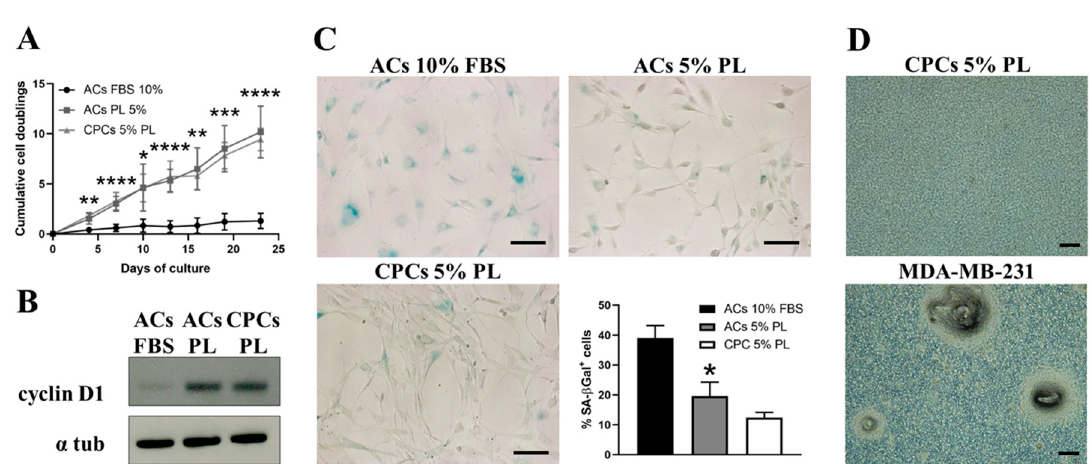
Figure 2. Growth rate and senescence profile of ACs and CPCs and in vitro tumorigenesis test on CPCs. ( A ) Growth kinetics plotted as number of cell duplications versus time of culture: black line indicates ACs expanded in presence of 10% FBS, grey line for ACs in 5% PL and light grey line for CPCs in 5% PL. Data are represented as mean ± SD ( N = 6, * p < 0.05, ** p < 0.01, *** p < 0.001 and **** p < 0.0001 versus ACs 10% FBS at the same time point by Student’s t -test analysis). ( B ) Representative images of the detection of cyclin D1 and α -tubulin as control by Western blot in cell lysates from all the examined groups ( N = 3). ( C ) Representative images of ACs 10% FBS, ACs 5% PL and CPCs 5% PL stained for senescence-associated SA- β gal and histogram showing the percentage of positive cells. Data are represented as mean ± SEM ( N = 5, * p < 0.05 versus ACs 10% FBS by Student’s t -test analysis). ( D ) Anchorage-independent growth in methylcellulose for CPCs (upper panel) and human MDA-MB-231 breast cancer cells as positive control (bottom panel) ( N = 3). All scale bars correspond to 100 µm.